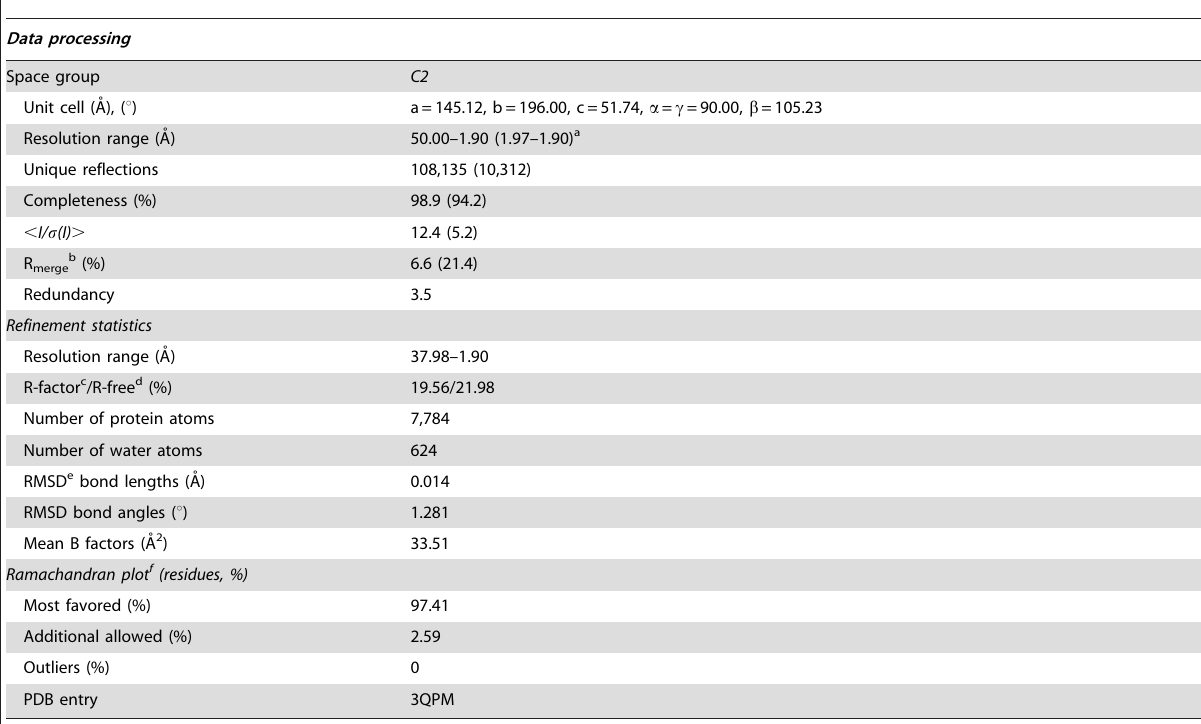
Table 1. Crystal parameters, data collection and structure refinement